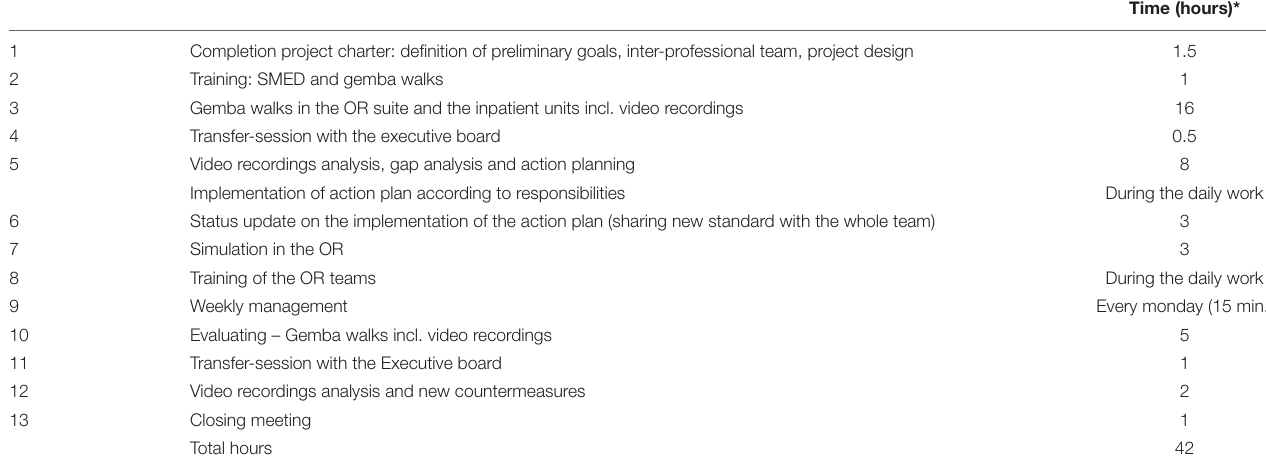
TABLE 3 | Time invested in the